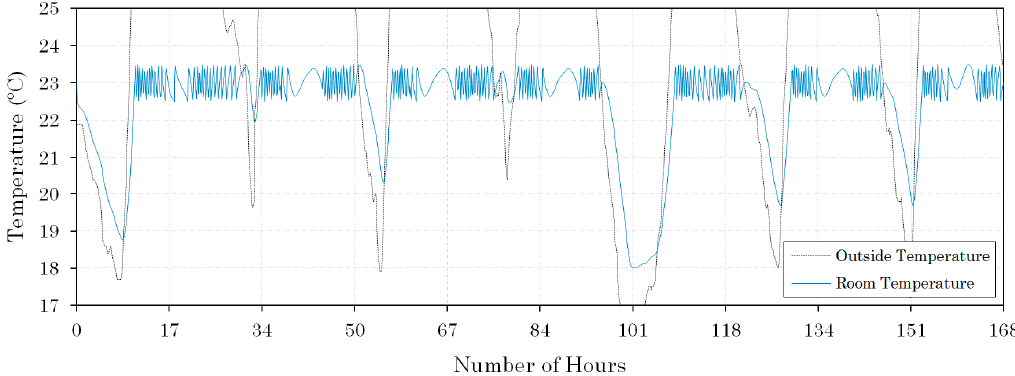
Figure 9. The temperature of the room by using ON/OFF control option.